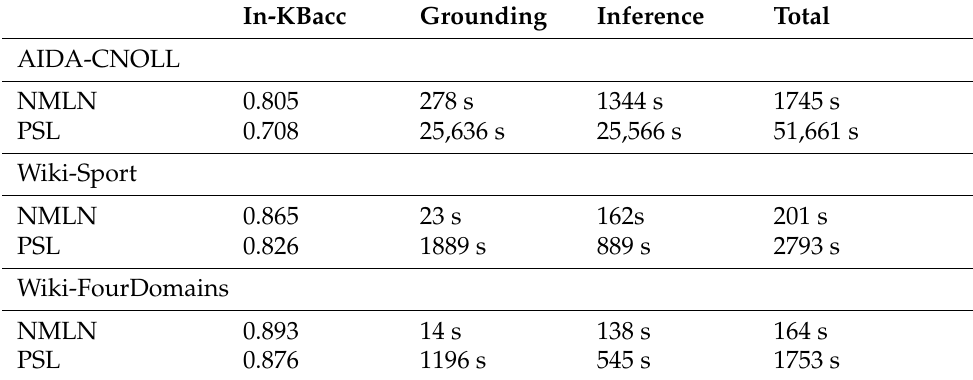
Table 4. Evaluation results on entity